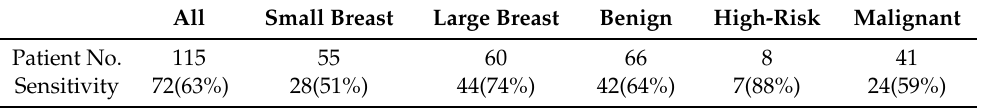
Table 1. Patient sensitivity